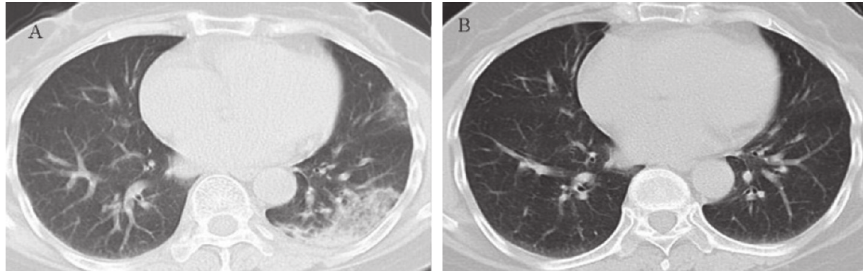
Figure 2: (a) At discharge, lung CTshowed high-density and patchy shadows in the left lung with blurred edges. (b) The lung lesions were absorbed by reexamination three months after discharge.